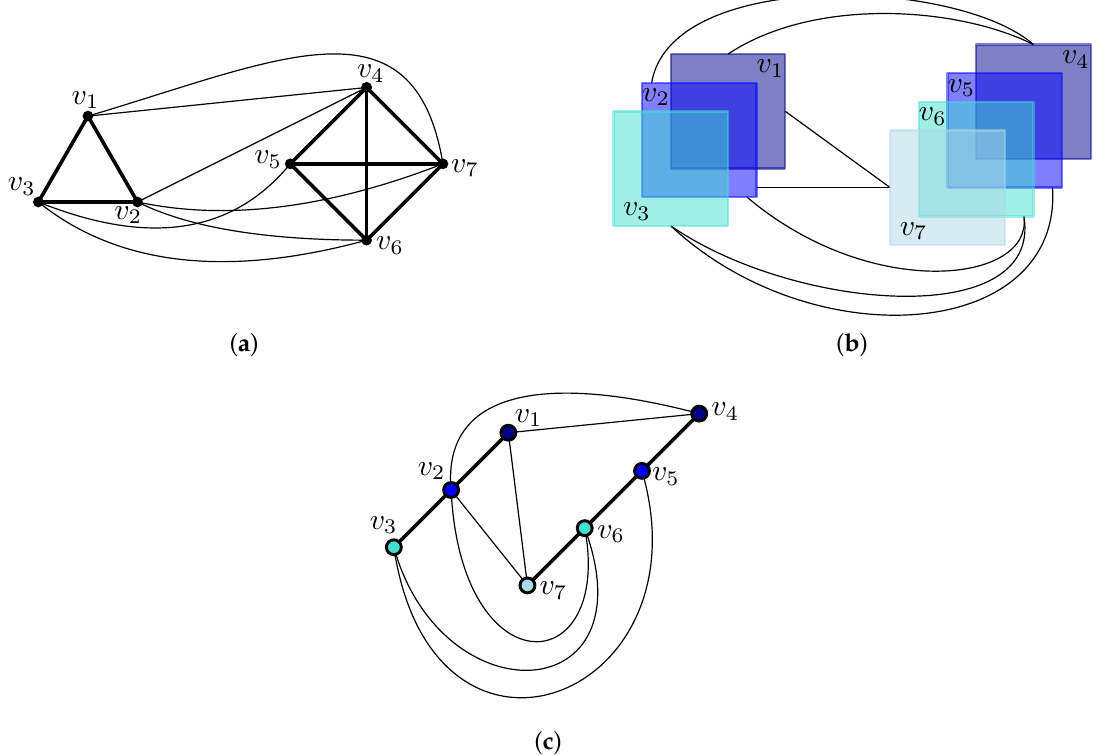
Figure 1. ( a ) A non-planar graph G . Cliques are highlighted with bold edges. ( b ) A clique-planar drawing of G . ( c ) Replacing each clique by a path spanning its vertices. Note that, different from ( a ), in ( c ), the first vertex and the last vertex of each path have only one place to connect to edges, while the interior vertices have two places: this is what makes the problem